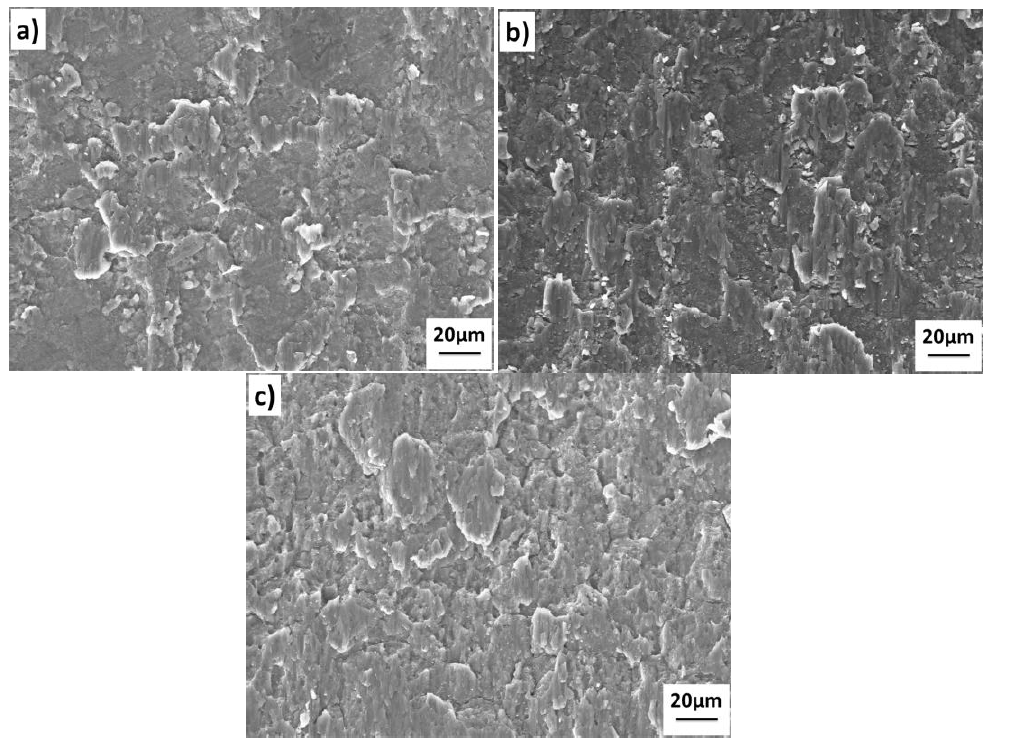
Figure 10. Shear test fractographs of the 1420-7B04 joints after bonded at different temperatures: ( a ) 460 °C; ( b ) 490 °C; ( c ) 520 °C.